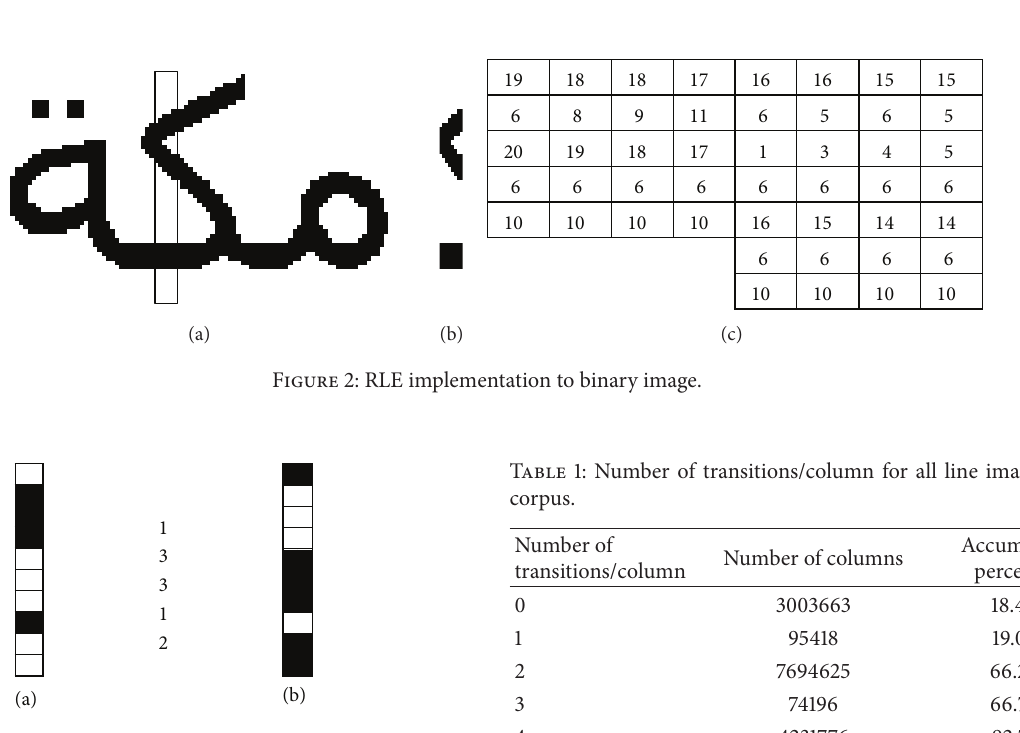
Figure 1: Implementing RLE to a gray image.